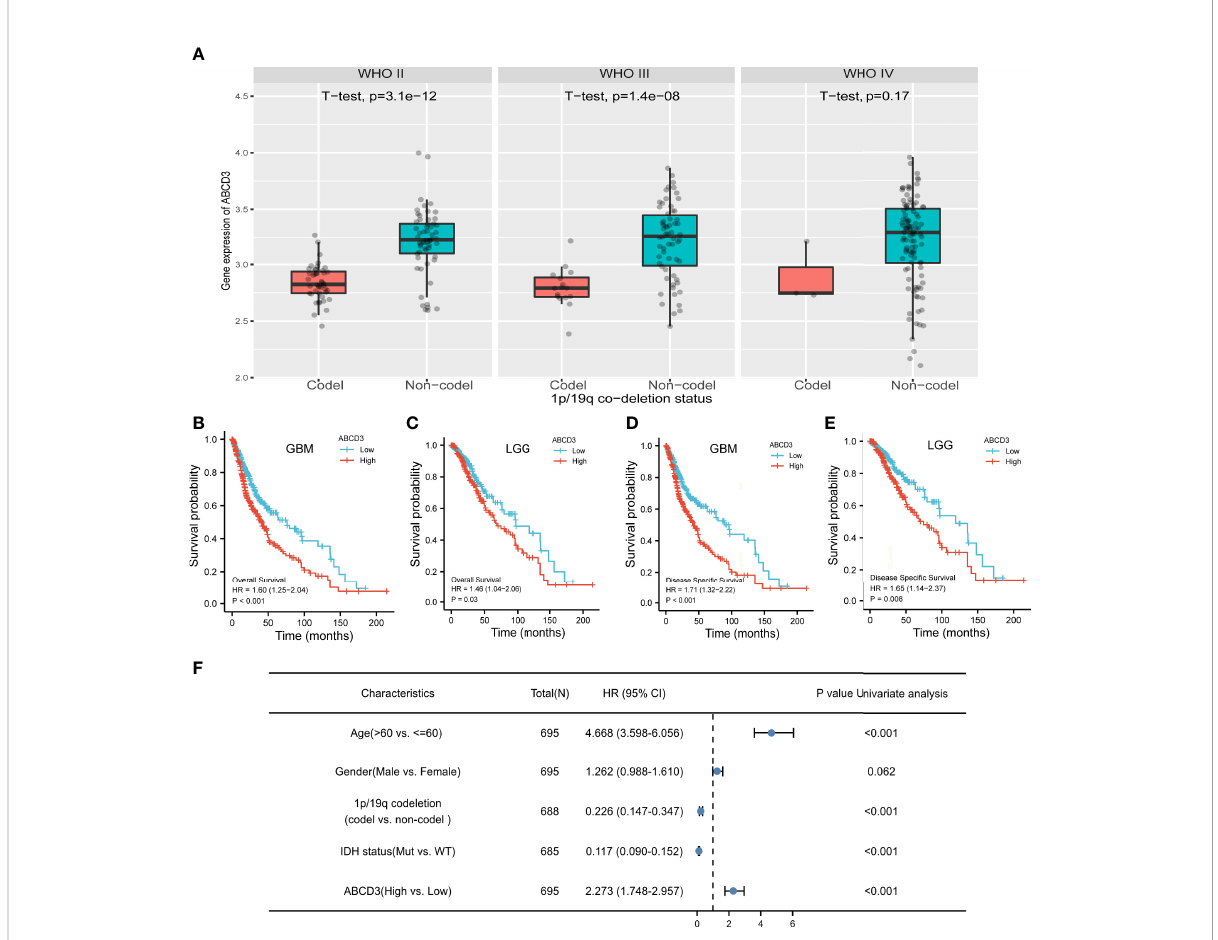
FIGURE 3 ABCD3 expression is associated with the clinical characteristics of glioma patients. (A) ABCD3 expression is lower in the 1p/19q co-deletion (Codel) groups than in the no co-deletion groups in all three WHO grade gliomas. (B – E) Overall survival and disease-speci fi c survival curve of GBM and LGG patients based on differential ABCD3 expression. (F) Univariate Cox analysis of ABCD3 expression and other clinical pathological factors for GBM and